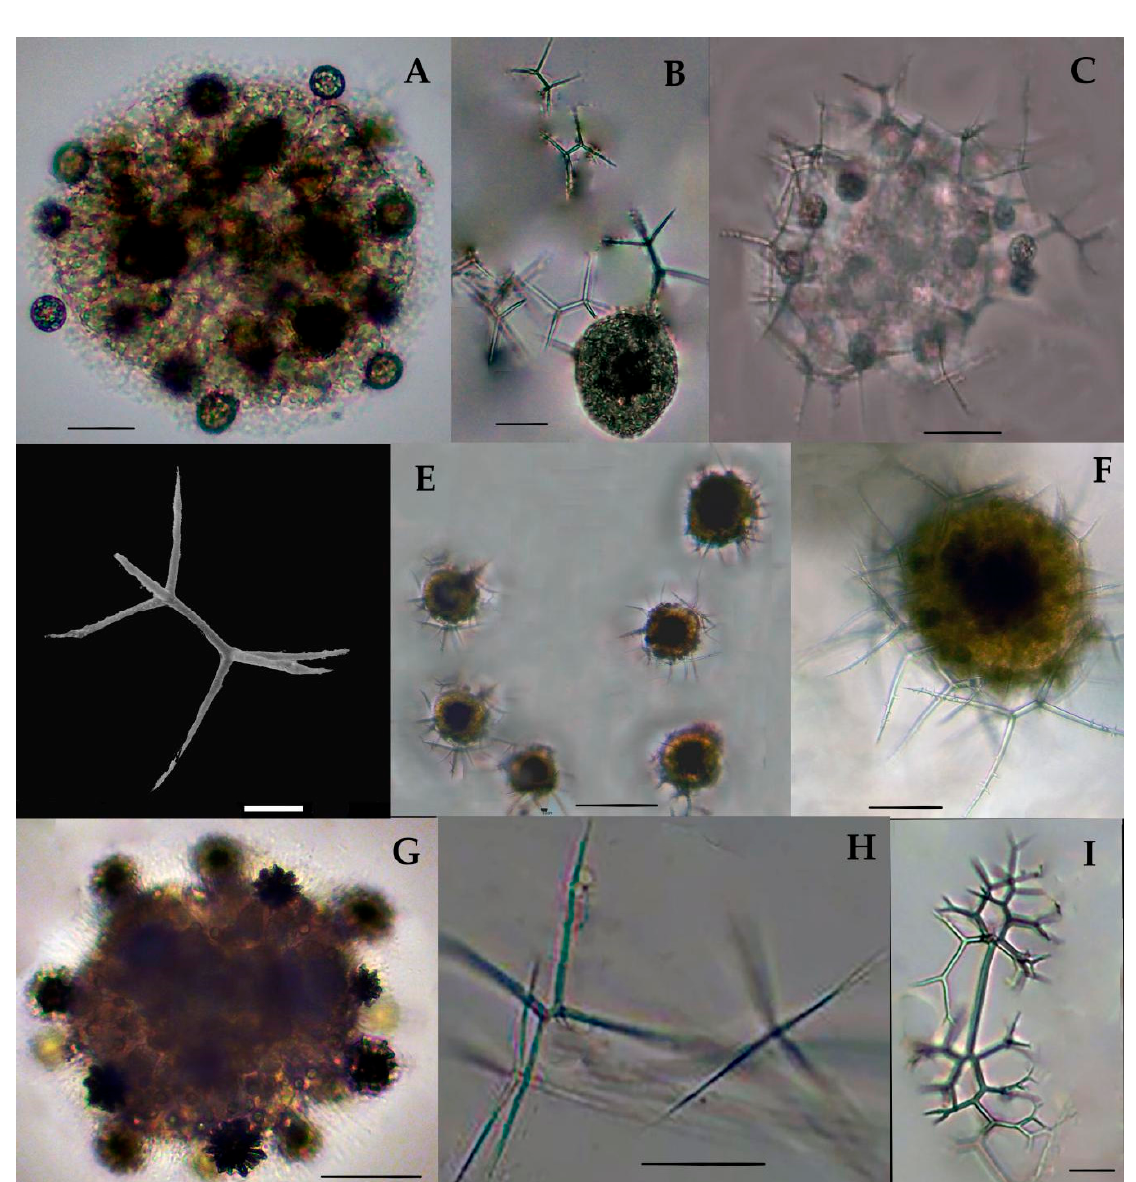
Figure 5. Photomicrographs of Collozoum ( A ) and Sphaerozoum ( B – G ) and Thallosoxanthium species ( H , I ). The images were modified from the Munir et al. [27]. ( A ) Collozoum inerme show non-spicule cells; ( B – D ) Sphaerozum punctatum show colonies and have intercapsulums with spicules; ( E , F ) Sphaerozum fuscum is formed of colonies of spherical shells with spicules; ( G ) Sphaerozum ovodimare has four ray spicules; ( H ) Thalassoxanthium cervicorne has two shanks at the end of the middle rod; ( I ) Thalassoxanthium octoceras has a four-triangular shank at both ends of the intermediate rod. Scale bars are 10 µm and 50 µm.